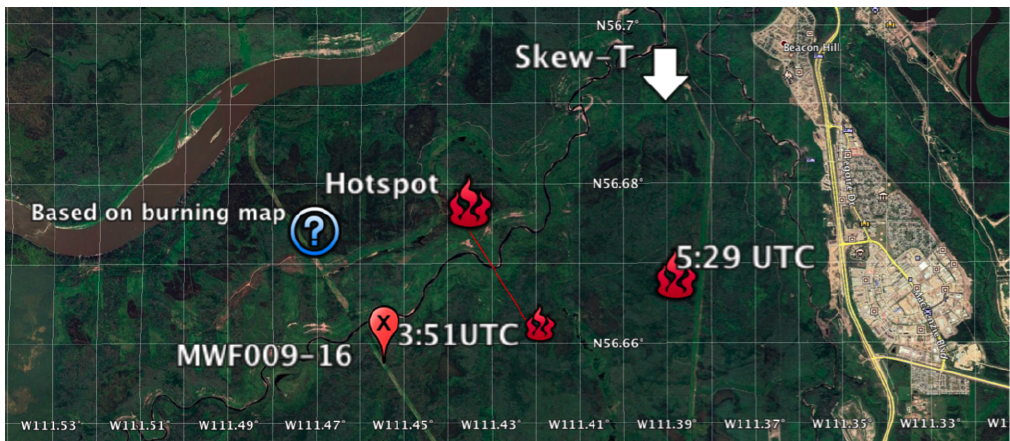
Figure 2. Location of hotspots and acquisition times of the reported fire. The question mark is the start point of the burned area at the time of reporting by the MWF009. The white arrow is the location of the model atmosphere profiles. Credit: Google Earth.